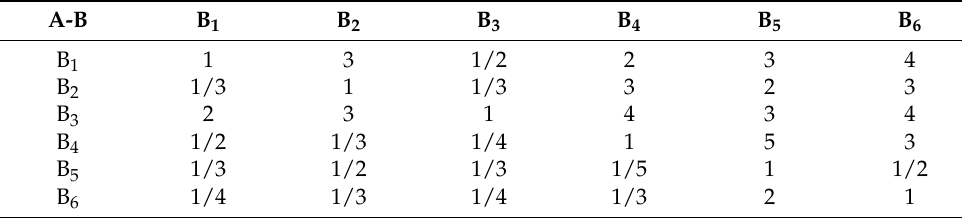
Table 3. A-B judgment